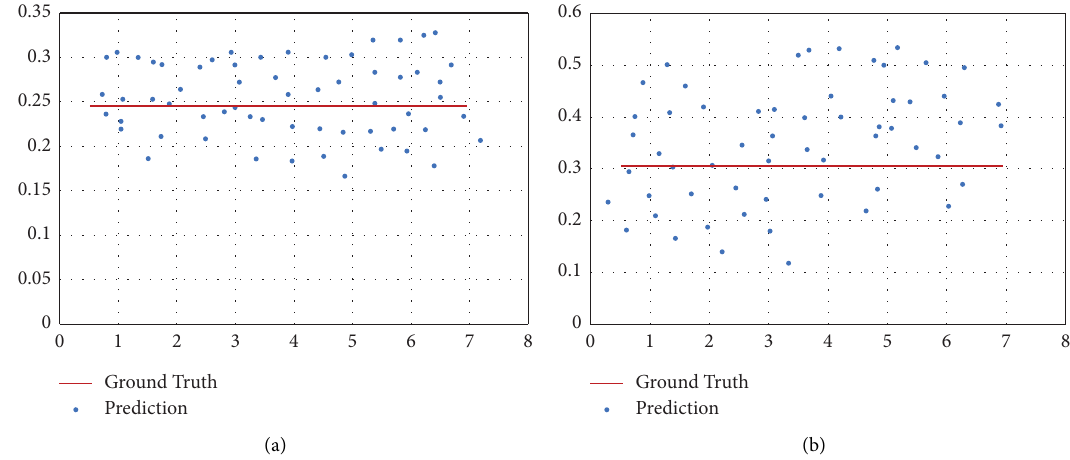
Figure 9: UWB positioning results (no NLOS). (a) Performing time synchronization. (b) Without performing time